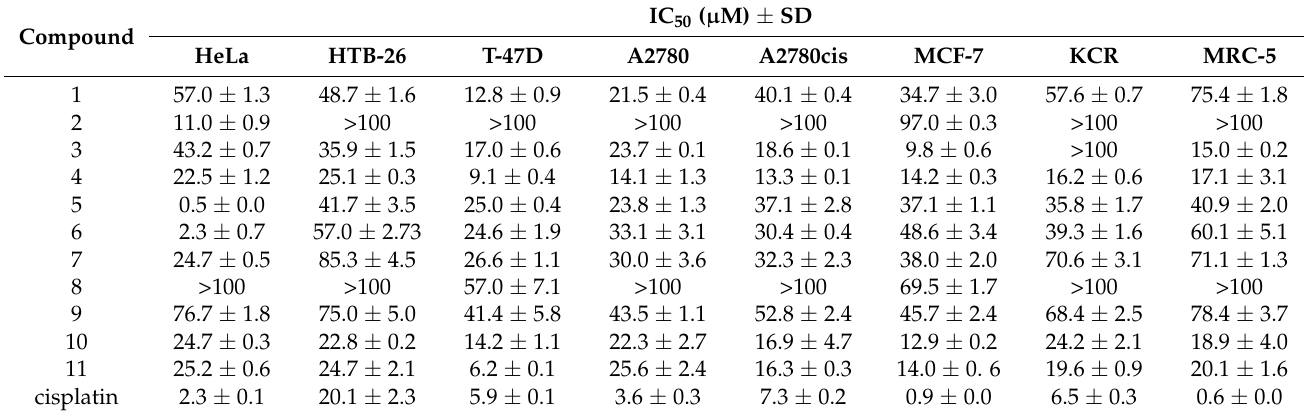
Table 3. Antiproliferative activity (IC 50 ) of the tested phenanthrenes 1 – 11